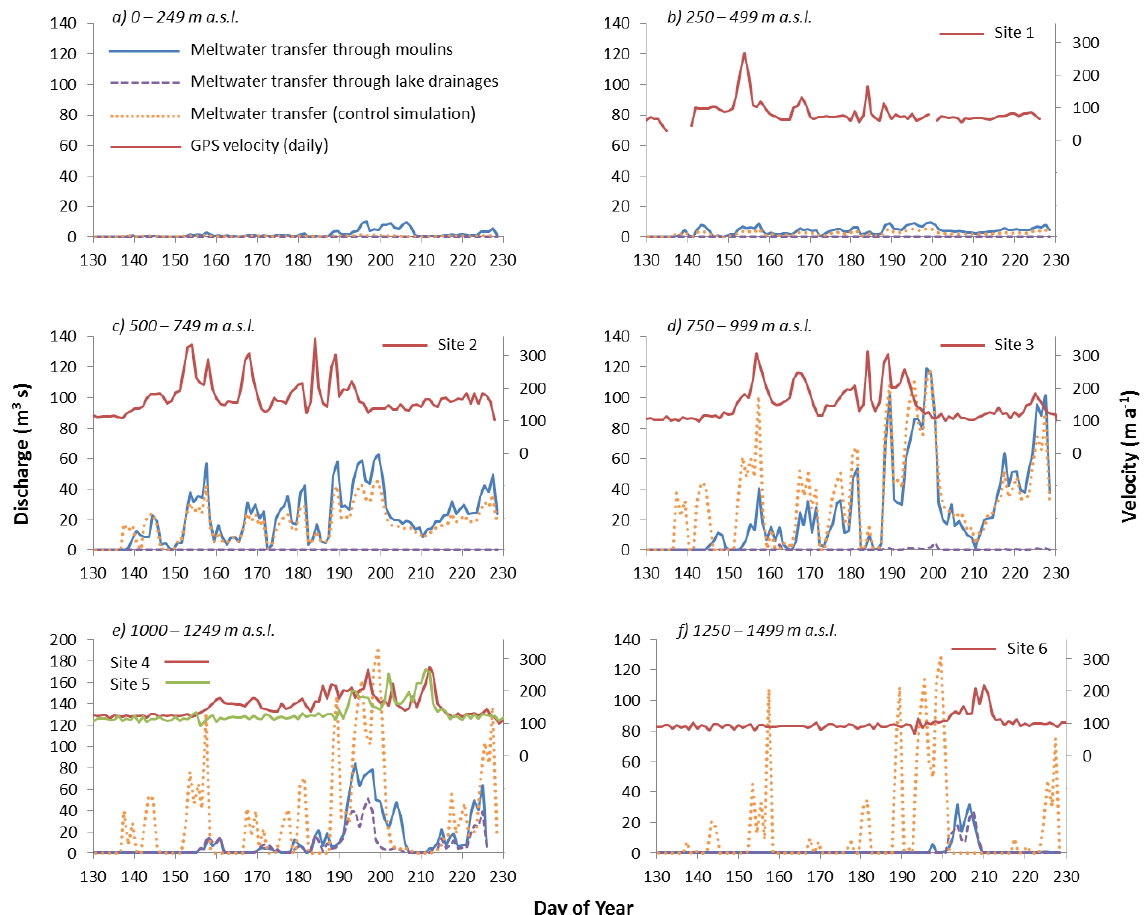
Figure 8. Supraglacial meltwater delivered to the bed each day through modelled lake drainages, moulins, and for the control simulation within ice surface elevation bands of 250m during 2009. Ice surface velocities from GPS sites 1–6 are plotted within their respective elevation bands (after Bartholomew et al., 2011b). Note the extended y -axis in (e)